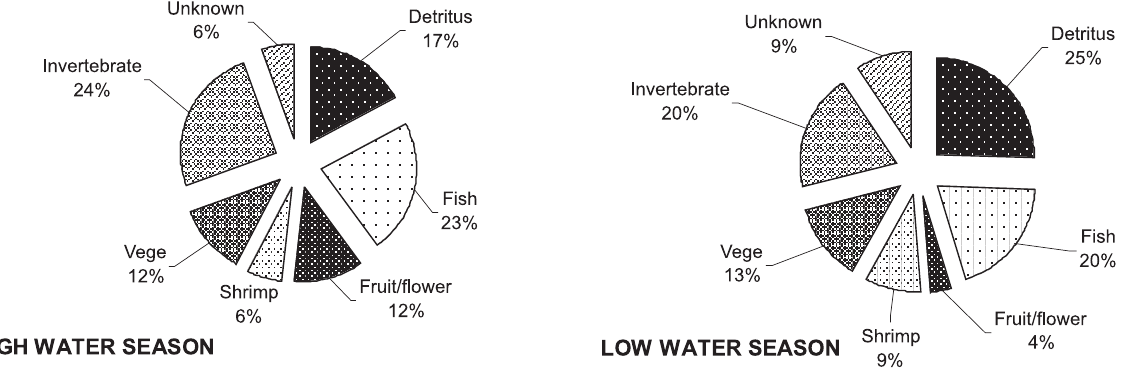
Fig. 2. Relative importance of food categories in supporting the community’s biomass of fish species inhabiting a floodplain lake (lago do Rei) in Central Amazonia in the two